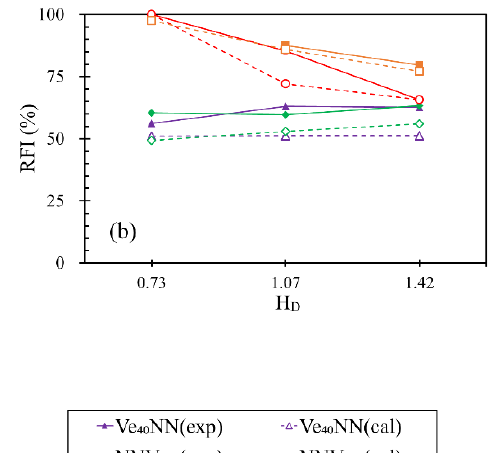
Figure 4. Time series of water levels in experiments (Zaha et al. [10]) and in simulation (this study). ( a ) Seaward vegetation